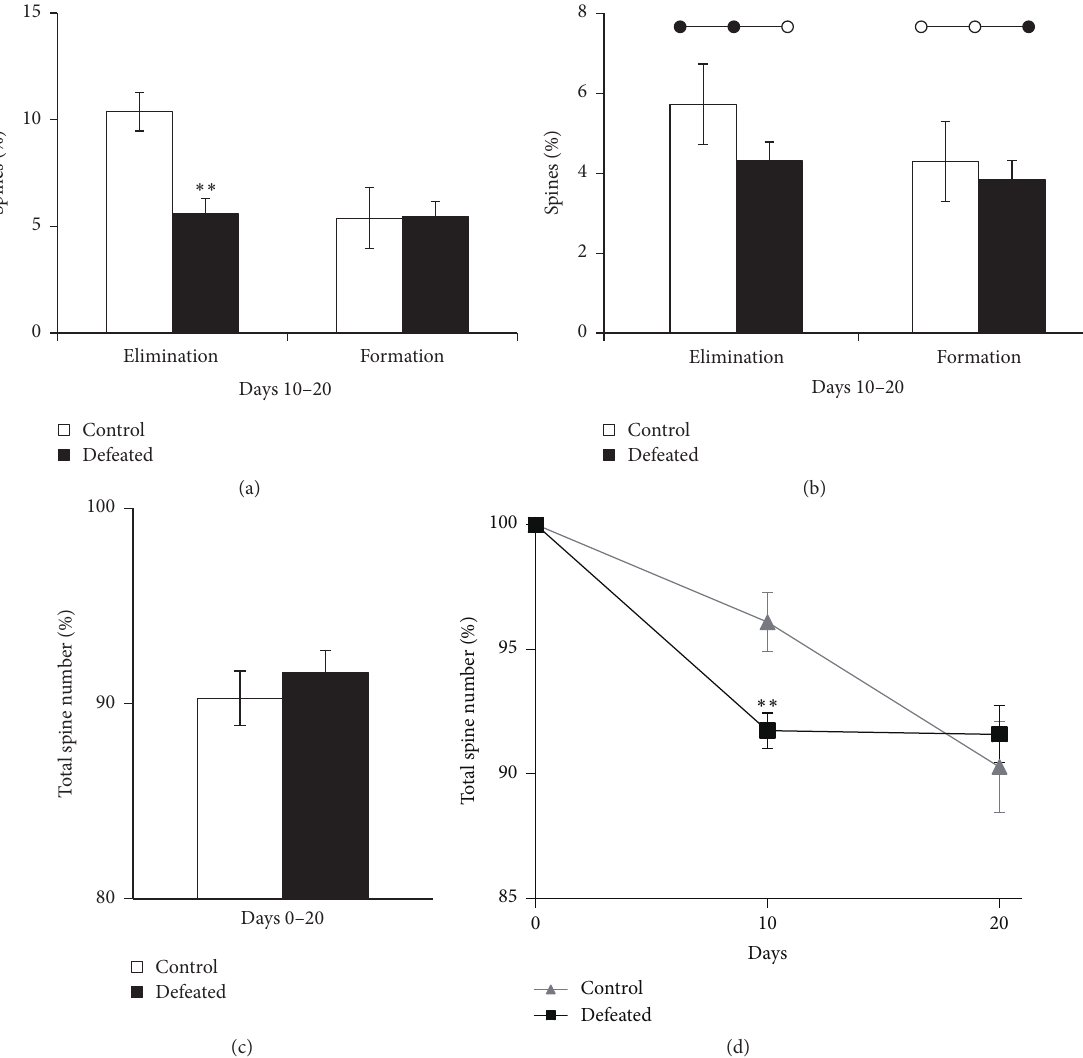
Figure 4: Turnover of FrA spines in control and defeated mice during recovery period. (a) Percentage of eliminated and formed spines over days 10–20 in control ( 𝑛 = 9 ) and defeated ( 𝑛 = 12 ) mice [Student’s 𝑡 -test: ∗∗ 𝑃 < 0.01 ]. (b) Percentage of net spine elimination and formation over days 10–20 in control ( 𝑛 = 9 ) and defeated ( 𝑛 = 12 ) mice. (c) Percentage of total spine number in FrA that remain stable at day 20 in control ( 𝑛 = 9 ) and defeated ( 𝑛 = 12 ) mice. (d) Change in total spine number during 20 days in the control ( 𝑛 = 9 ) and the defeated mice ( 𝑛 = 12 ). The defeated mice experienced CSDS during day 0–day 10 and then recovery period during day 10–day 20. [Two-way repeated measure ANOVA: time 𝐹(1, 19) = 10.57 , 𝑃 = 0.004 . CSDS 𝐹(1,19) = 0.444 , 𝑃 = 0.51 . Time × CSDS interaction 𝐹(1,19) = 9.90 , 𝑃 = 0.005 . Student’s 𝑡 -test: ∗∗ 𝑃 < 0.01 for control versus defeated mice on day 10.]